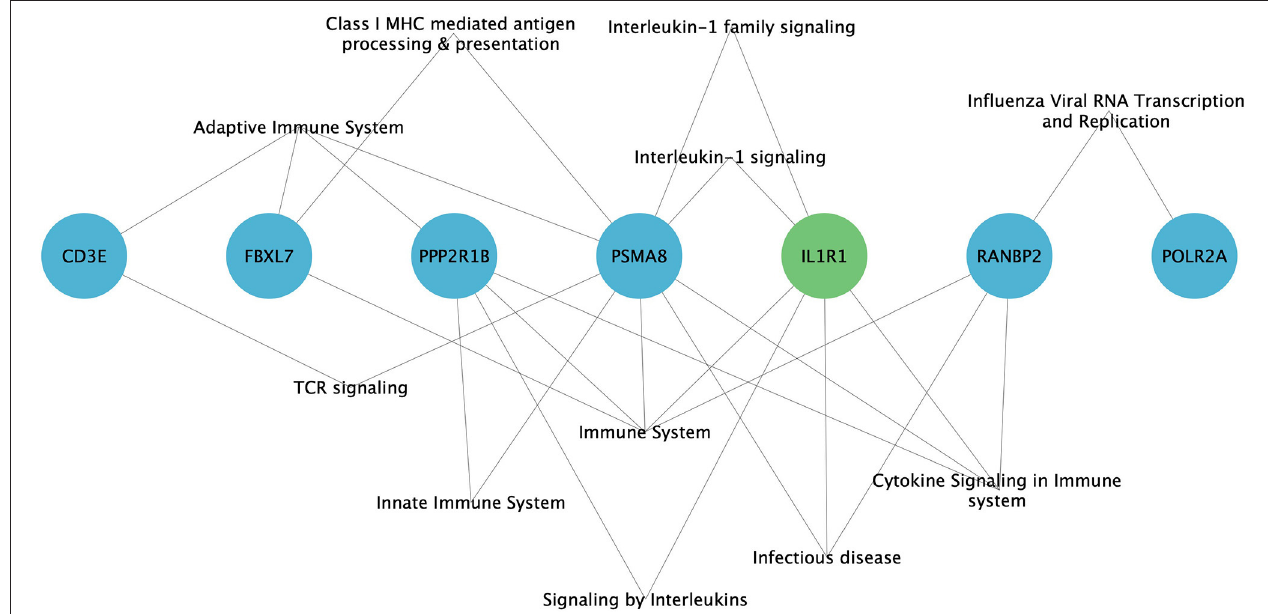
FIGURE 4 | Enrichment of immune system-related pathways in hub genes of family A (green) and family B (blue), visualized using Cytoscape 3.8.2 software.